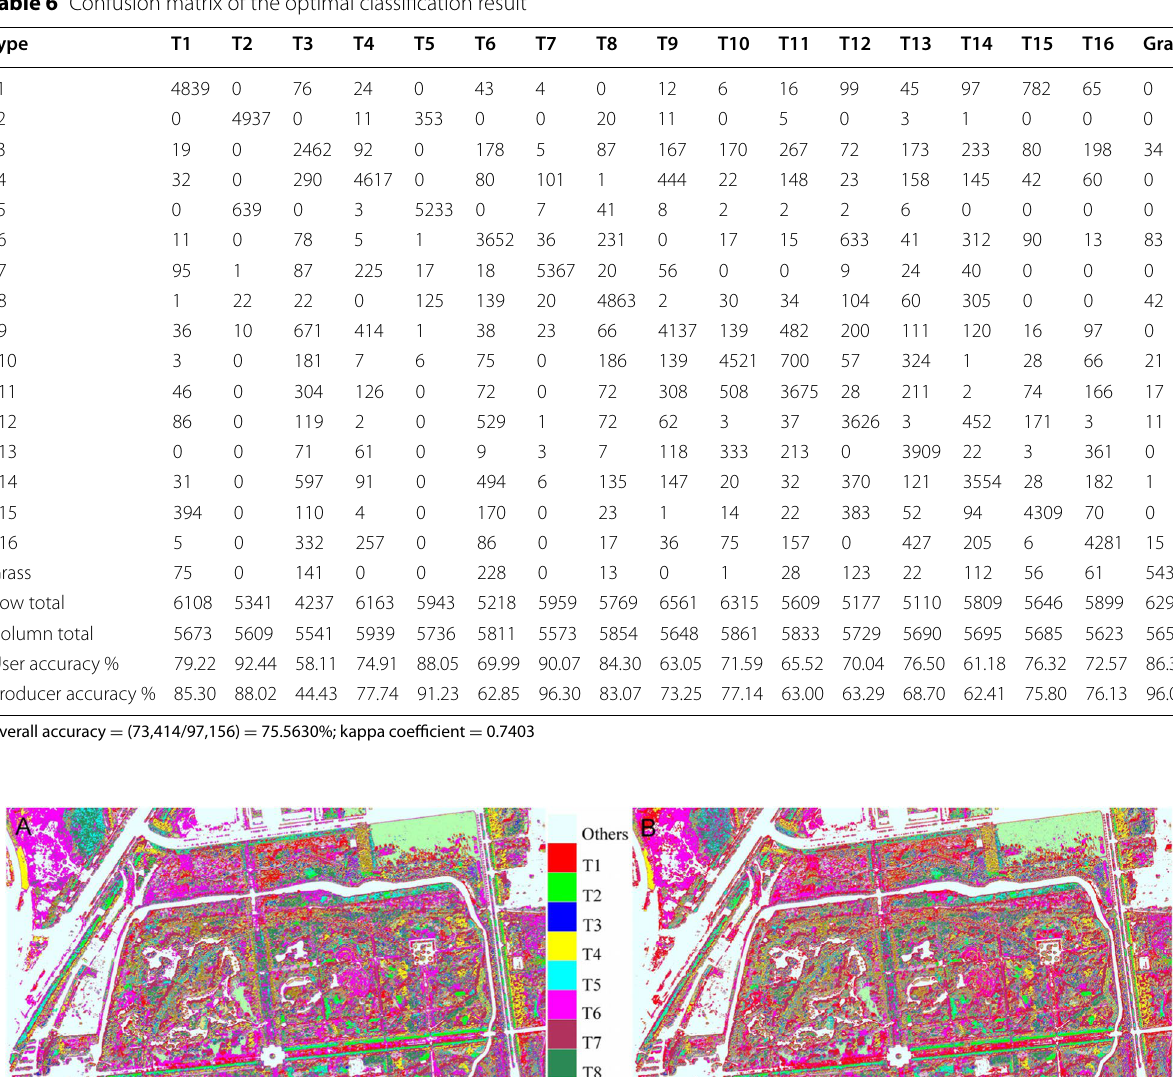
Table 6 Confusion matrix of the optimal classification result